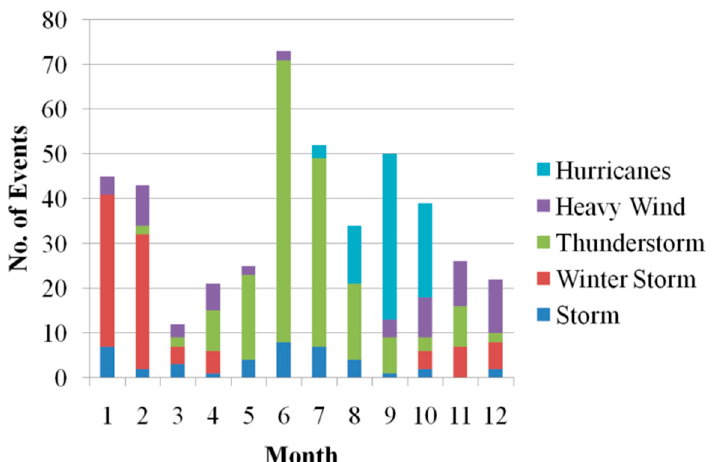
Figure 3. Monthly frequency distribution of the top five categories of severe-weather-related natural disasters.